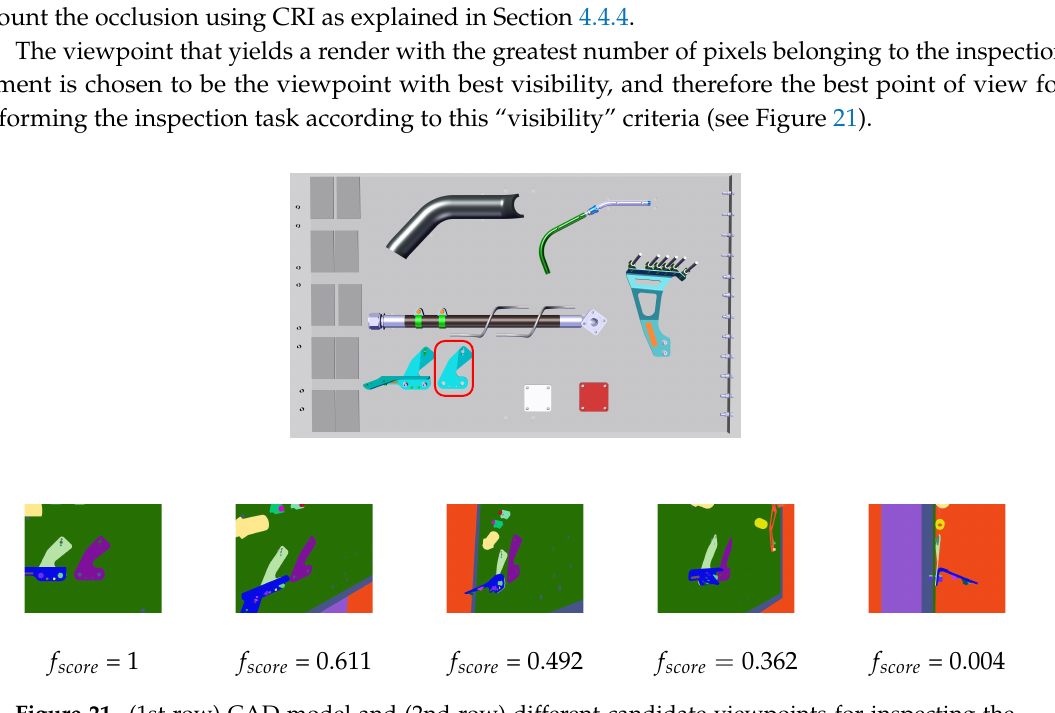
Figure 21. (1st row) CAD model and (2nd row) different candidate viewpoints for inspecting the element in the red rectangle, with the corresponding f score